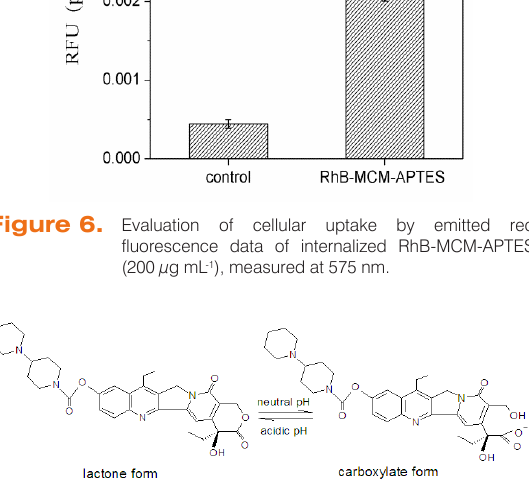
Scheme 1. pH-dependent forms of